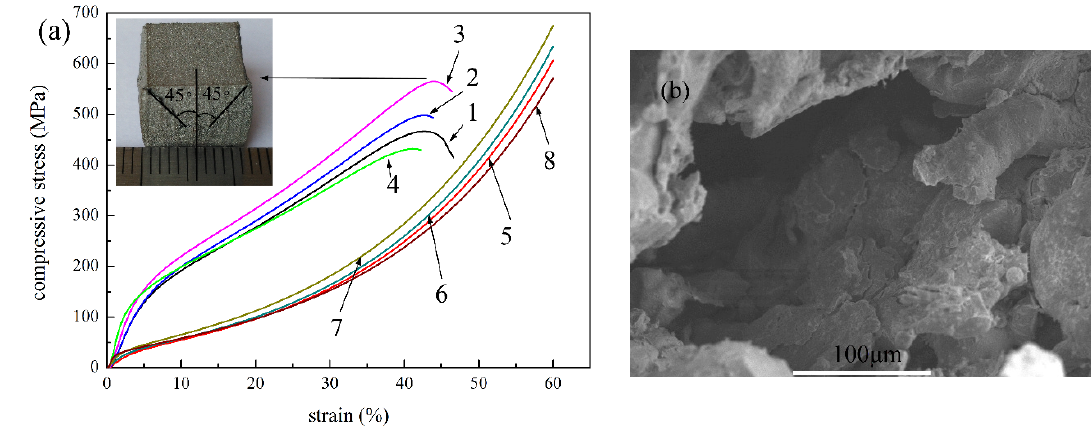
Figure 6. ( a ) Compressive curves of the compacted samples: after nitriding: sample 1 (curve 1); sample 2 (curve 2); sample 3 (curve 3); sample 4 (curve 4); before nitriding: sample 1 (curve 5); sample 2 (curve 6); sample 3 (curve 7); sample 4 (curve 8); ( b ) the cracking character picture of the nitrided sample 2 after compression test.